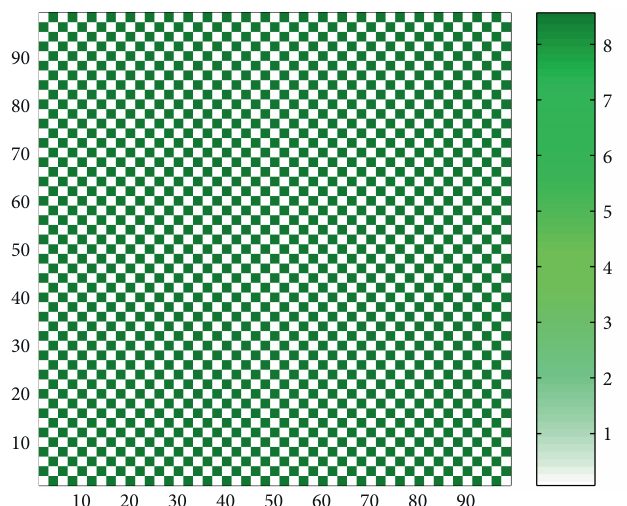
Figure 4: Regular mosaic vegetation pattern self- organized on flat ground, with application of IC1 or IC2 𝑎 = 2, 𝑚 = 0.45, 𝑑 = 0.35, 𝑡 = 800